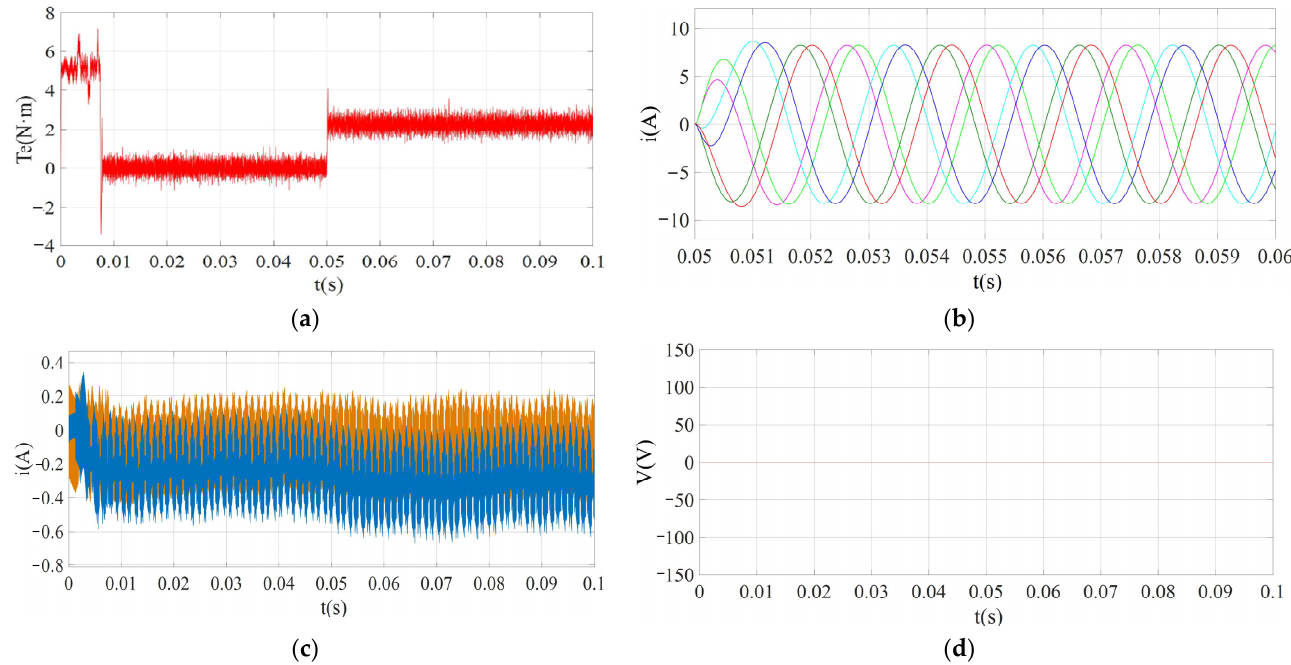
Figure 11. Output performance of MPTC2: ( a ) output torque; ( b ) six-phase stator current; ( c ) harmonic current components in x-y subplace; ( d ) common-mode voltage.